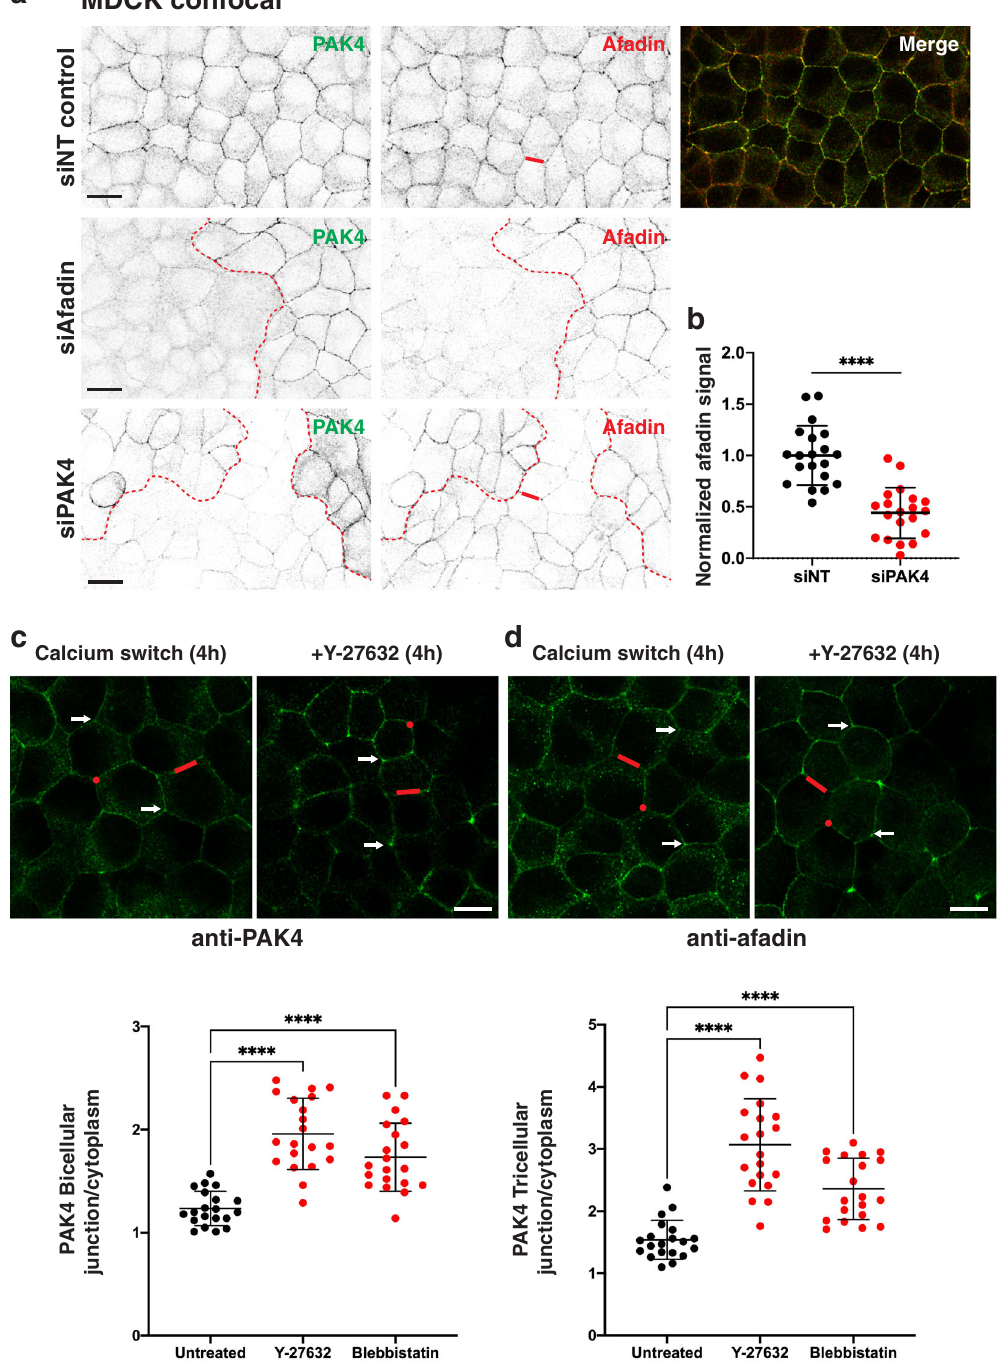
with unregulated kinase for extended periods. In order to inves- tigate potential feedback between the acto-myosin network and the localization of PAK4, we chemically inhibited myosin II directly or by through its regulatory kinase ROCK. Short-term (20 min) inhibition of ROCK (10 μ M Y27632) is suf fi cient to abolish actomyosin arrays in MDCK cells with prominent loss of myosin IIB from bicellular and tricellular junctions 88 . MDCK clones lacking ZO-1 have enhanced acto-myosin, suggesting ZO- 1 normally functions to suppress the local Shroom – ROCK pathway 88